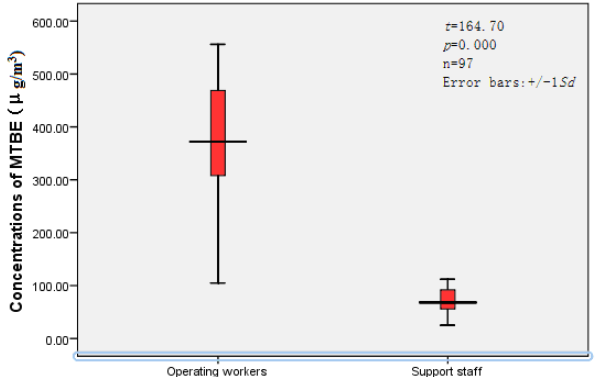
Figure 2. Average concentrations of personal exposure to MTBE in operating workers and support staff at the investigated petrol